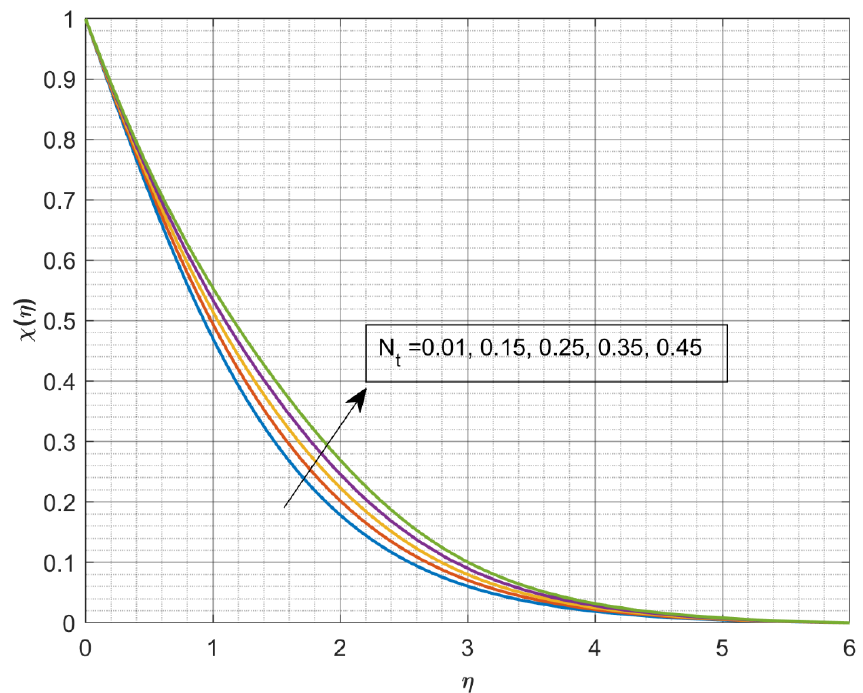
Figure 10. Influence of N t on χ ( η ) . Table 3 portrays the numerical values of f (cid:48)(cid:48) with respect to pertinent varied parameters. The upsurge in the values of λ and β 2 reduces f (cid:48)(cid:48) , but the contrary tendency is detected for upward β 1 values. The numerical values of θ (cid:48) with respect to pertinent varied parameters are shown in Table 4. The escalation in the values of λ and β 2 declines θ (cid:48) , but the inverse trend is detected for the upward values of Q , β 1 , and λ E . The numerical value of χ (cid:48)